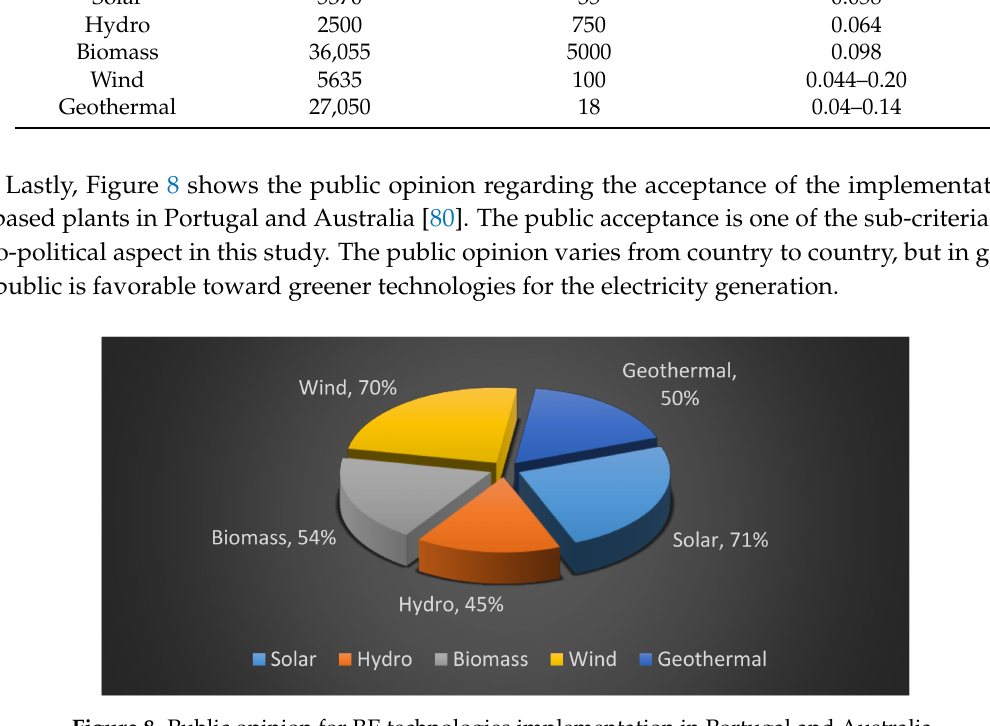
Figure 8. Public opinion for RE technologies implementation in Portugal and Australia.